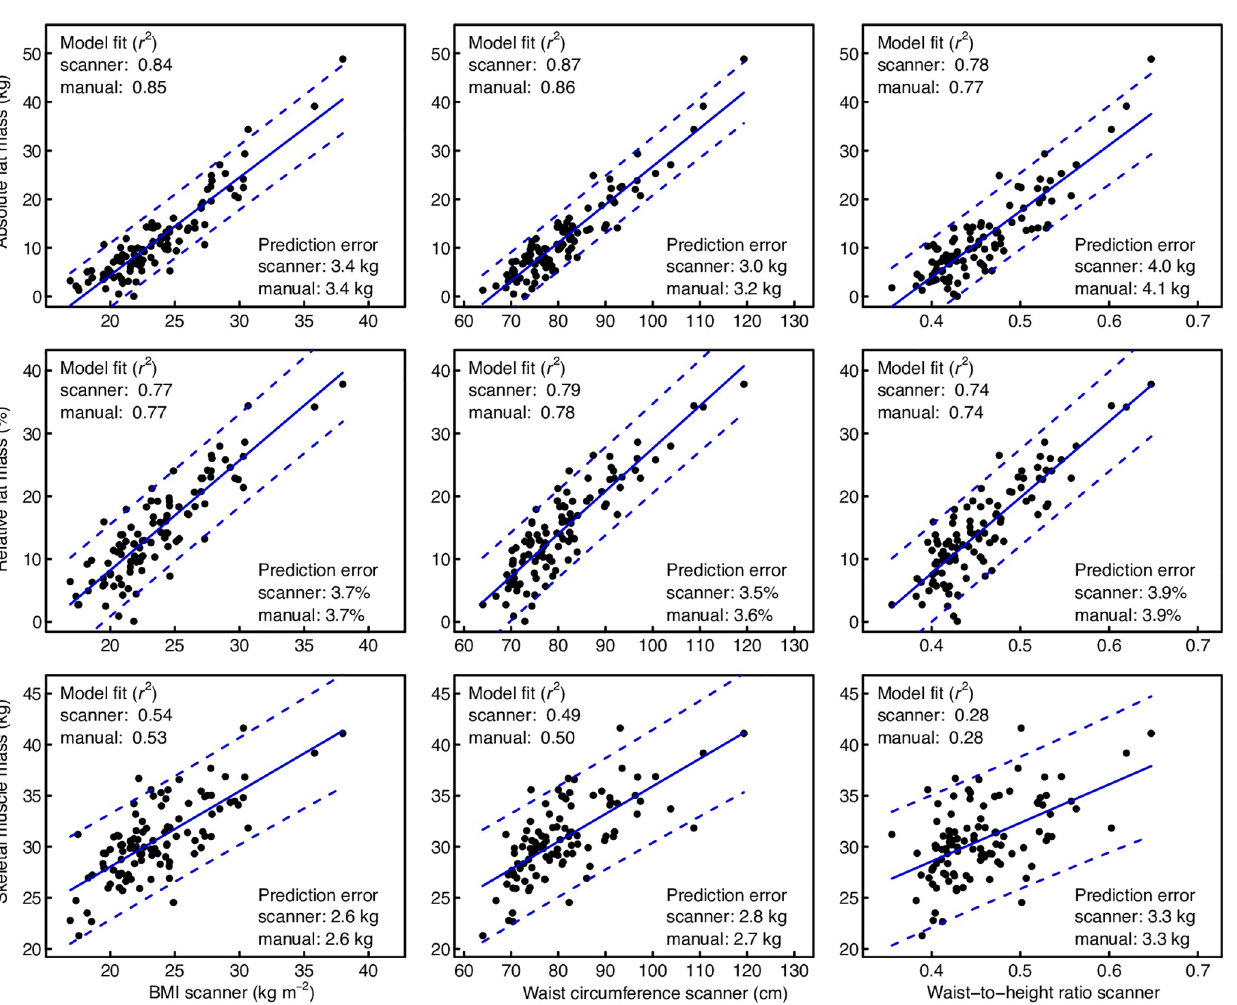
Fig 2. Relationships between body composition (fat or muscle mass as determined through bioimpedance analysis) and three standard anthropometric measurements determined either with the 3D body scanner or through manual measurements. Segmented regression was used for visceral fat, and linear regression for the other body composition measures. The fit of each regression model is given as explained variation (r 2 ), and its predictive value is given as the prediction standard error, i.e. the square root of the mean squared prediction error obtained by leave-one-out cross-